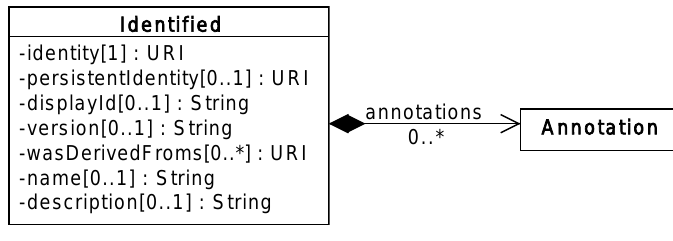
Figure 4: Diagram of the Identified abstract class and its associated